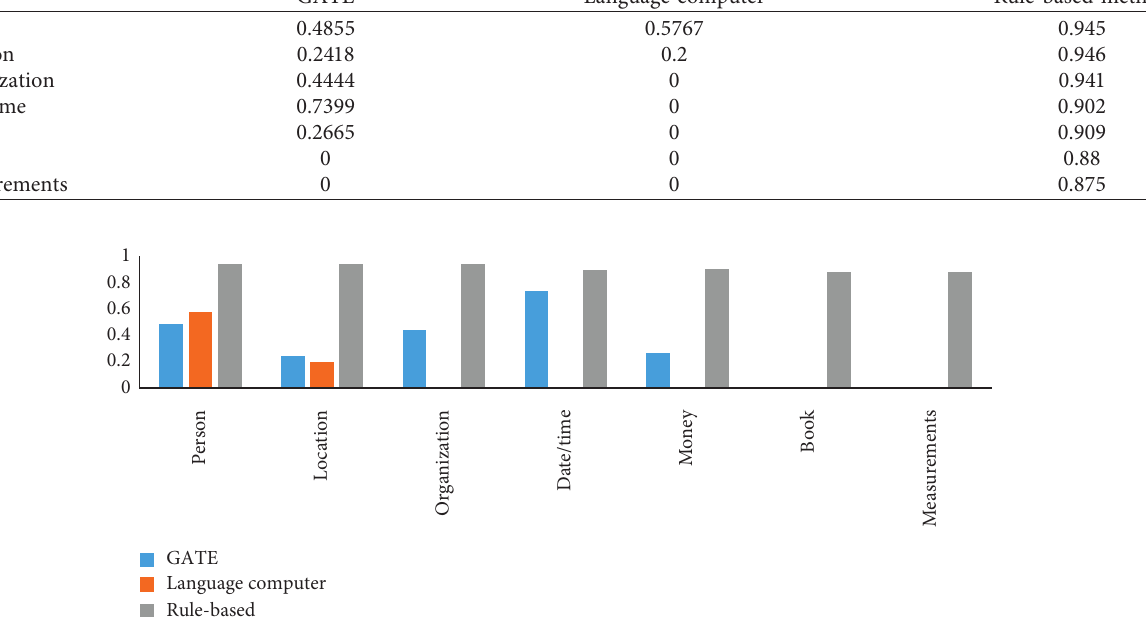
Figure 14: Comparison between baseline analysis and rule-based